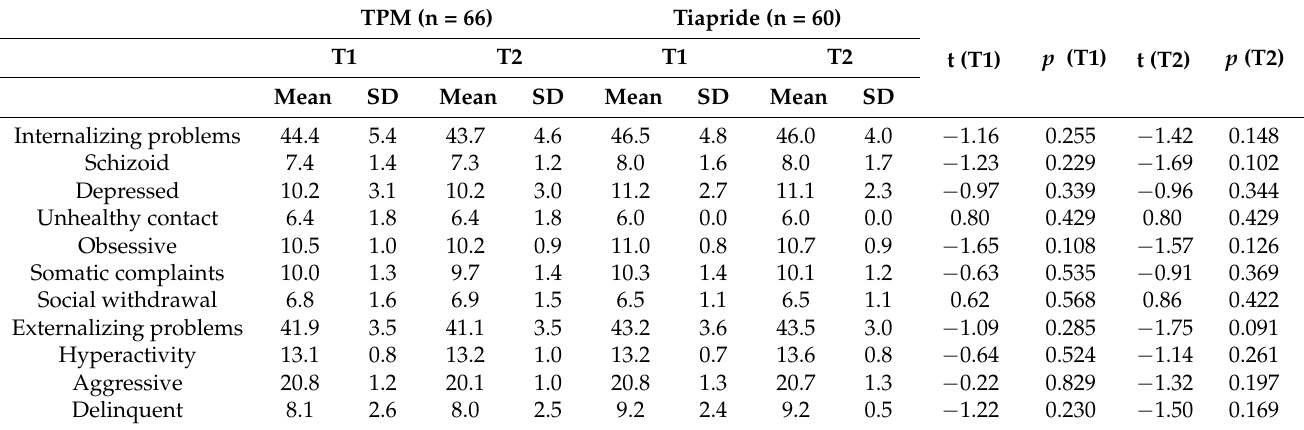
Table 4. Comparison of the CBCL scores between TPM group and Tiapride group. TPM (n =